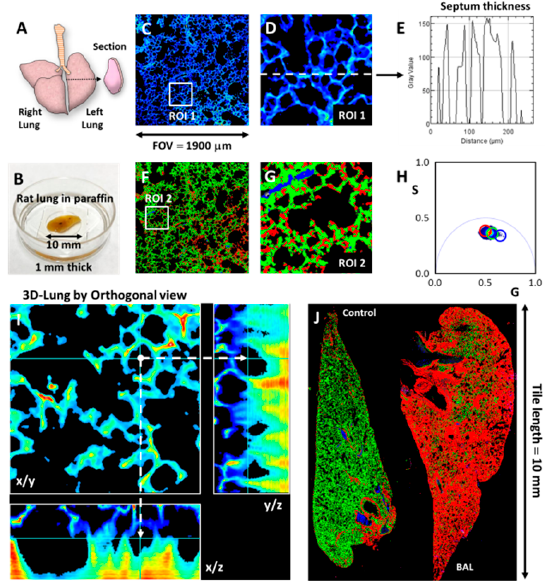
Figure 5. FLIM-Phasor Lung analysis of NADH autofluorescence. ( A ) Illustration of a rat lung and the region from where the section for para ffi n inclusion was obtained. ( B ) Picture of the rat lung section included in para ffi n and placed in the dish for imaging. ( C ) Large field of view (FOV) FLIM image of lung using Zeiss ECPlan-NEOFLUAR 10x / 0.3 objective. The region of interest (ROI 1) is the region shown in section D. ( D ) The dashed line is showing the profile of intensity to quantify the septum thickness. ( E ) Septum thickness plot. ( F ) Pseudocolor image generated by the cursor selection at the phasor plot in H. ( G ) Zoom in of the ROI 2 in (F). ( H ) FLIM-Phasor plot. The cursors select di ff erent lifetimes. ( I ) Orthogonal views of the lung 3D image. The arrows indicate an alveolus. ( J ) Pseudocolor images of control and injured rat lungs by broncho-alveolar lavage. The colors indicate di ff erences in the